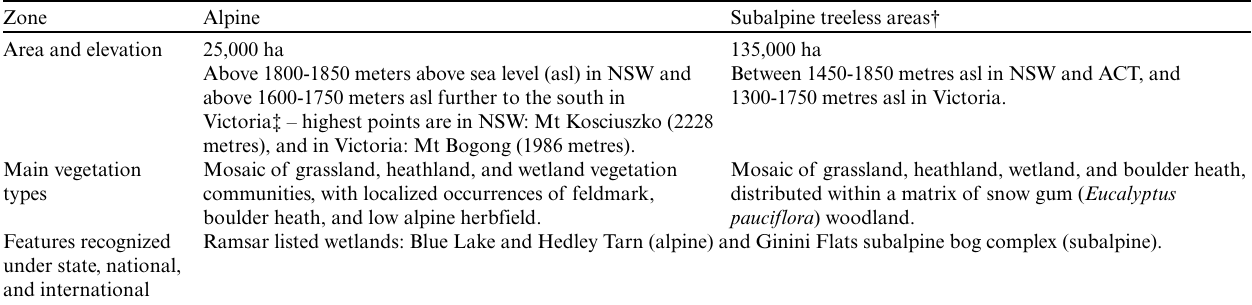
Table 1 . Biodiversity features of the Alps focal system. Zone Alpine Area and